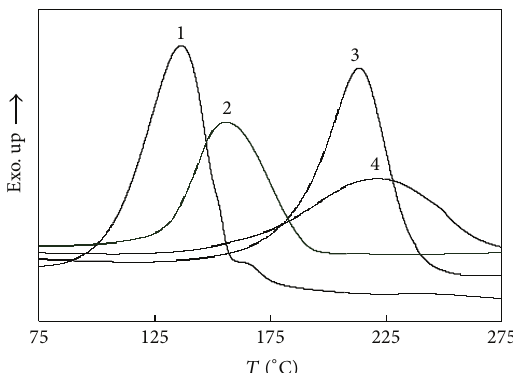
Figure1:DSCcurvesofcuringreactionofIMTHPA-curedED-20resininthepresenceofcatalysts:(1)1-butyl-3-methylimidazoliumbromide; (2) 1-butyl-3-methylimidazolium orthophosphate; (3) 1-butyl-3-methylimidazolium tetrafluoroborate; (4) 1-butyl-3-methylimidazolium sulfate.